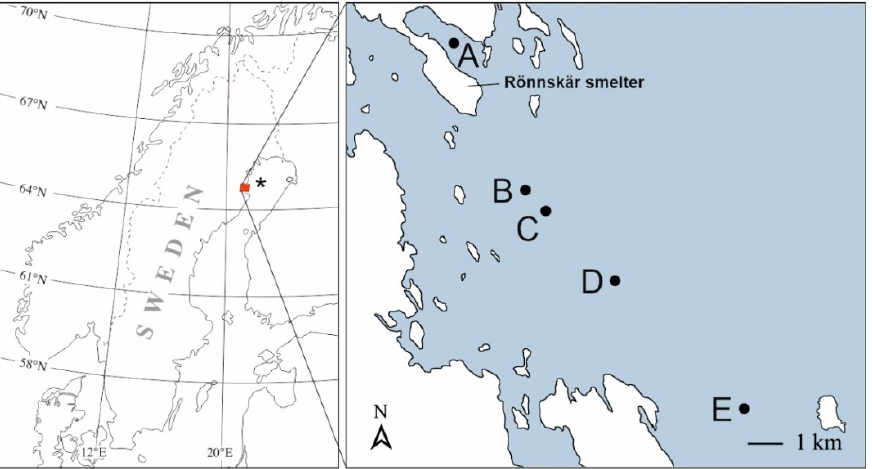
Figure 1. Map of the Rönnskär smelter—Bothnian Bay area in northern Sweden. Sampling locations of transect sediment cores are marked A–E. Brackish water sampled in the Skelleftehamn harbor basin (Site A), and Bothnian Bay “clean” reference water at the site marked *.